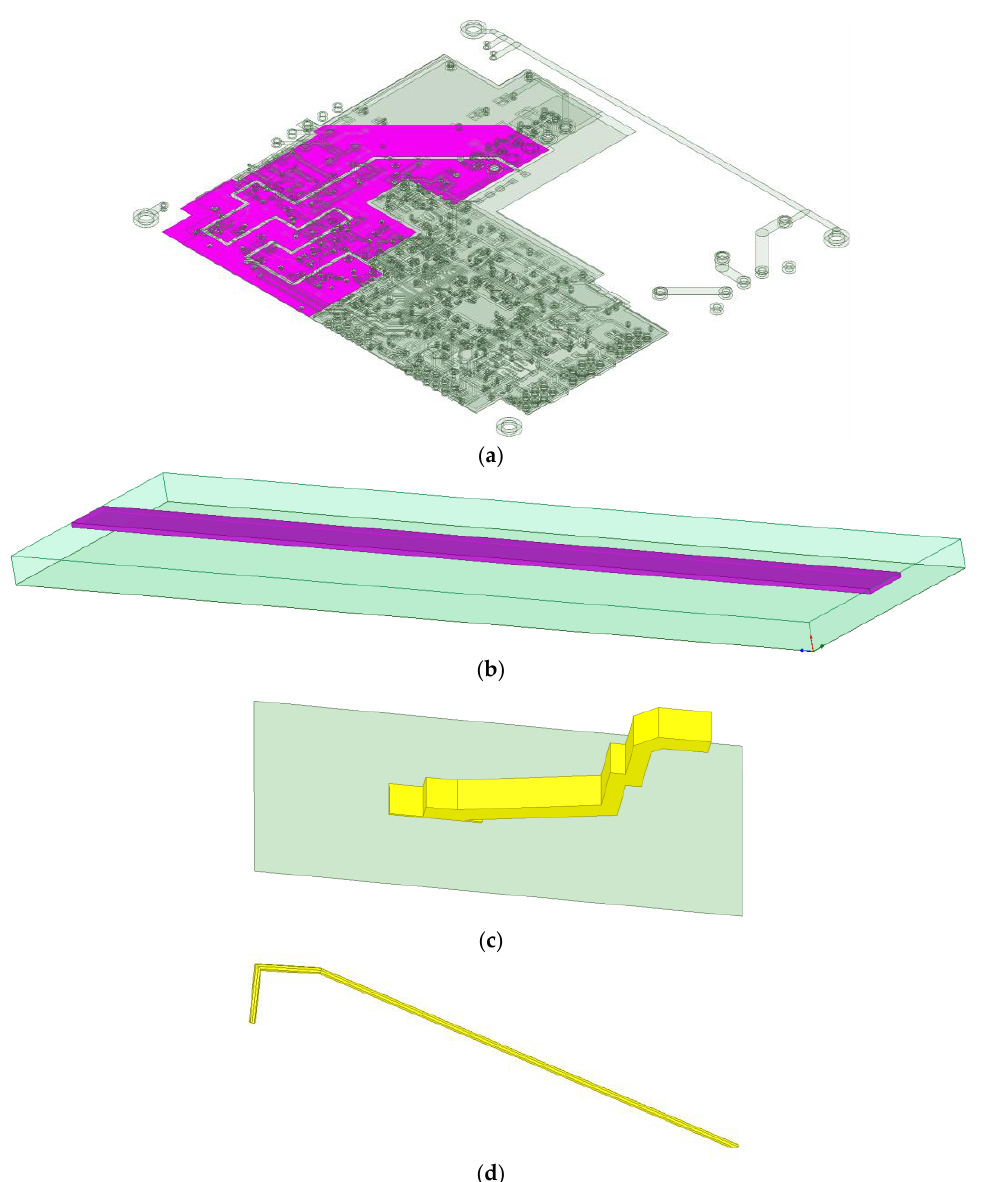
Figure 16. Model of the key coupling loop of the acquisition card’s PCB: ( a ) PCB; ( b ) PCB trace; ( c ) ADC chip pin; ( d ) ADC bonding wire.